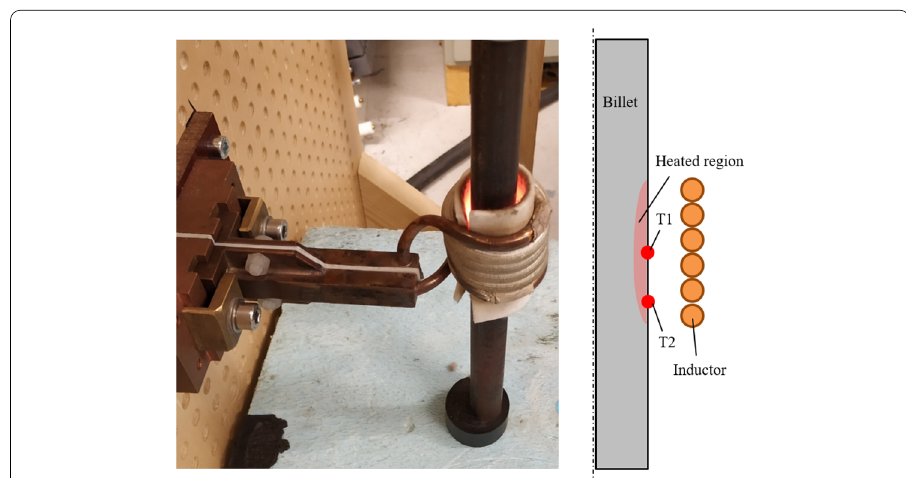
Fig. 6 Experimental set-up (right) and position of thermocouples (left)